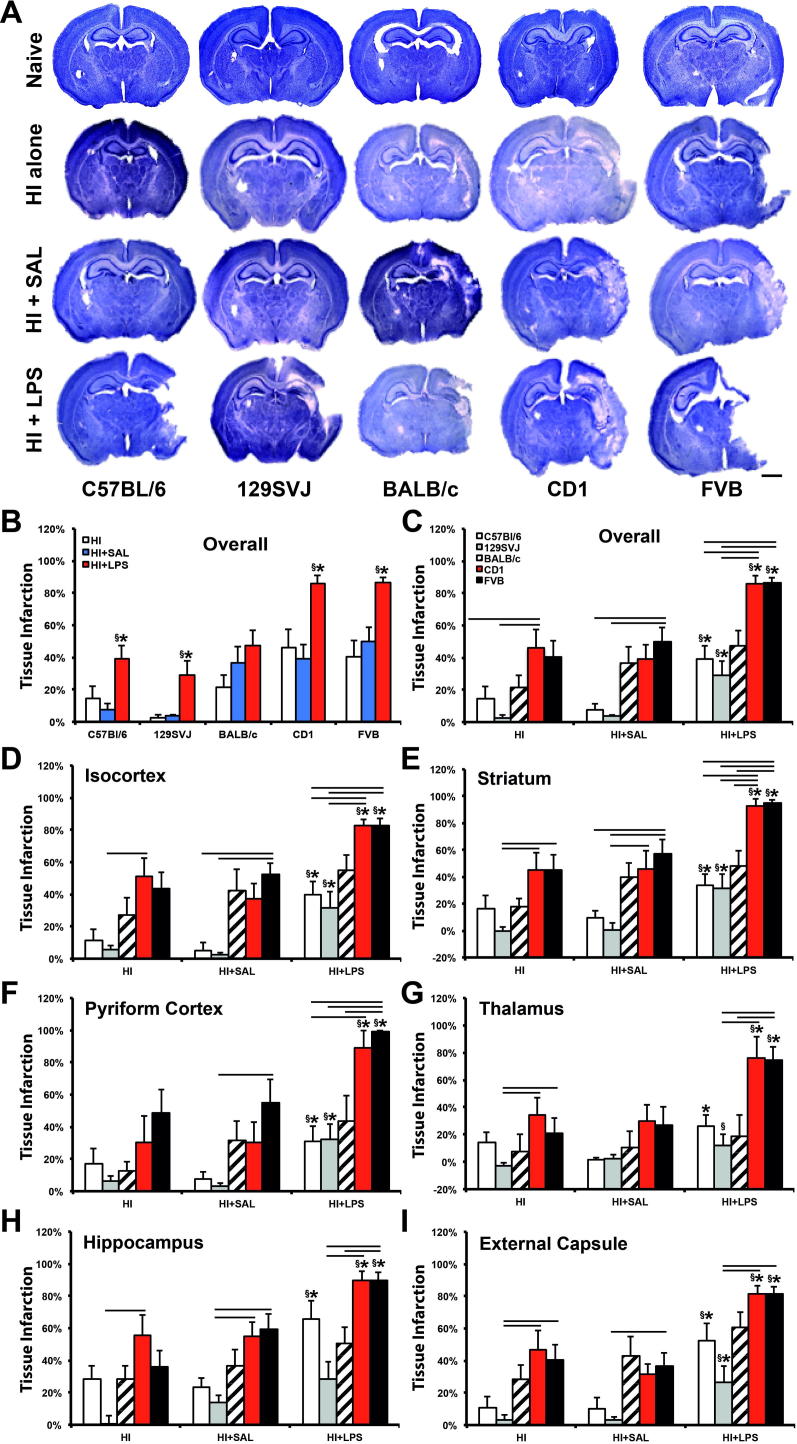
Pre-treatment with LPS 12 h prior to hypoxia–ischemia in postnatal day 7 mice normally results in augmented brain infarction across different mouse strains. (A) Nissl staining of mouse forebrains of C57BL/6, 129SVJ, BALB/c, CD1 and FVB strains 48 h following hypoxia–ischemia. Coronal hemisphere sections (40 μm) at the level of the cortex and beginning of the hippocampus; the upper row shows untreated naïve animals, second row mice exposed to hypoxic–ischemic insult alone (HI alone), third row those injected 12 h earlier with saline (HI + SAL), and lower row with pre-treatment of 0.6 μg LPS/g body weight (HI + LPS). (B, C) Infarct volume assessment of overall tissue loss per strain (B) and per treatment (C). (D–I) Individual forebrain regions in isocortex (D), pyriform cortex (F), hippocampus (H), striatum (E), thalamus (G) and external capsule (I) as percentage of that region on the contralateral hemisphere. Just minimal tissue loss was observed in 30 min hypoxia–ischemia alone and the HI + SAL groups in the mouse strains of C57BL/6 (n = 10 and 11 animals, respectively) and 129SVJ (10/10), but this increased, moderately, in the BALB/c (11/9), CD1 (10/12) and FVB (9/11). LPS pre-treatment strongly sensitized to hypoxia–ischemia insult, with statistical significance in C57BL/6 (n = 11), 129SVJ (n = 10), CD1 (n = 10) and FVB (n = 11) LPS-treated animals when compared to the saline-injected controls and to HI alone animals. BALB/c mice (n = 10) did not show significantly increased LPS-mediated tissue infarction. Compared with animals not injected prior to hypoxia–ischemia, Saline administration revealed no effect overall (B–I). p < 0.05 for Kruskal–Wallis one-way analysis, followed by Dunn multiple comparison test (∗for HI + LPS vs. HI + SAL, §for HI + LPS vs. HI alone, #for HI + SAL vs. HI alone, overhead bar for interstrain treatment comparison). Bar scale = 1.2 mm.